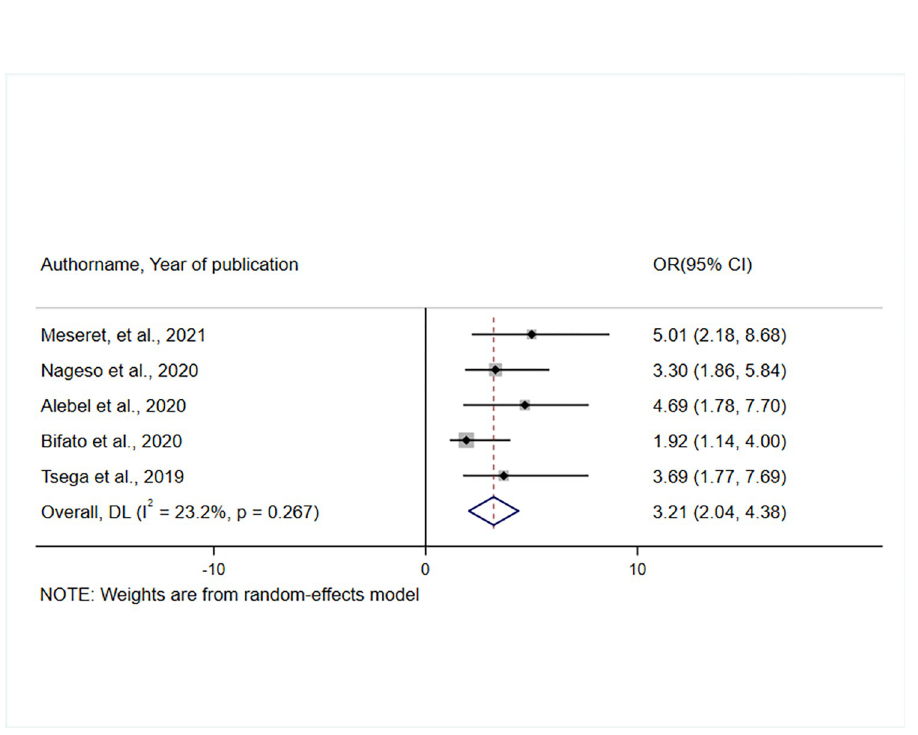
Fig 9. Forest plot showing the association between perceived service quality and enrolment in the CBHI scheme in Ethiopia, 2017–2022.